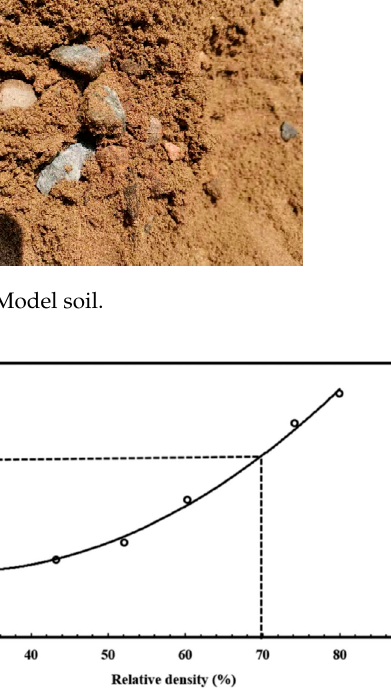
Figure 4. Variation of relative density of sand with the height of free fall (Plaban Deb, 2020) [12].